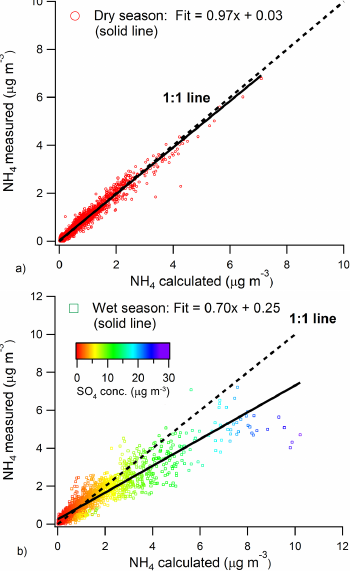
Fig. 5. Measured vs. calculated NH + using (a) Eq. (3) (dry season) and (b) Eq. (4) (wet season). Data points (b) are colour-coded according to SO 2